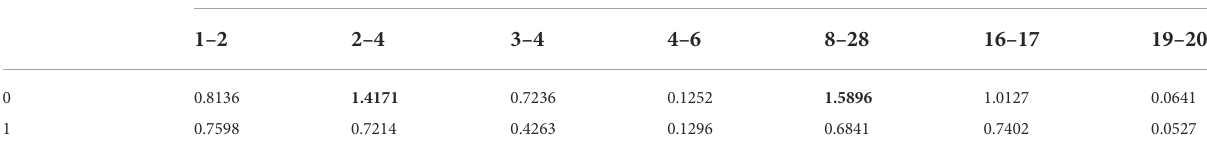
TABLE 3 Partial line power comparison.